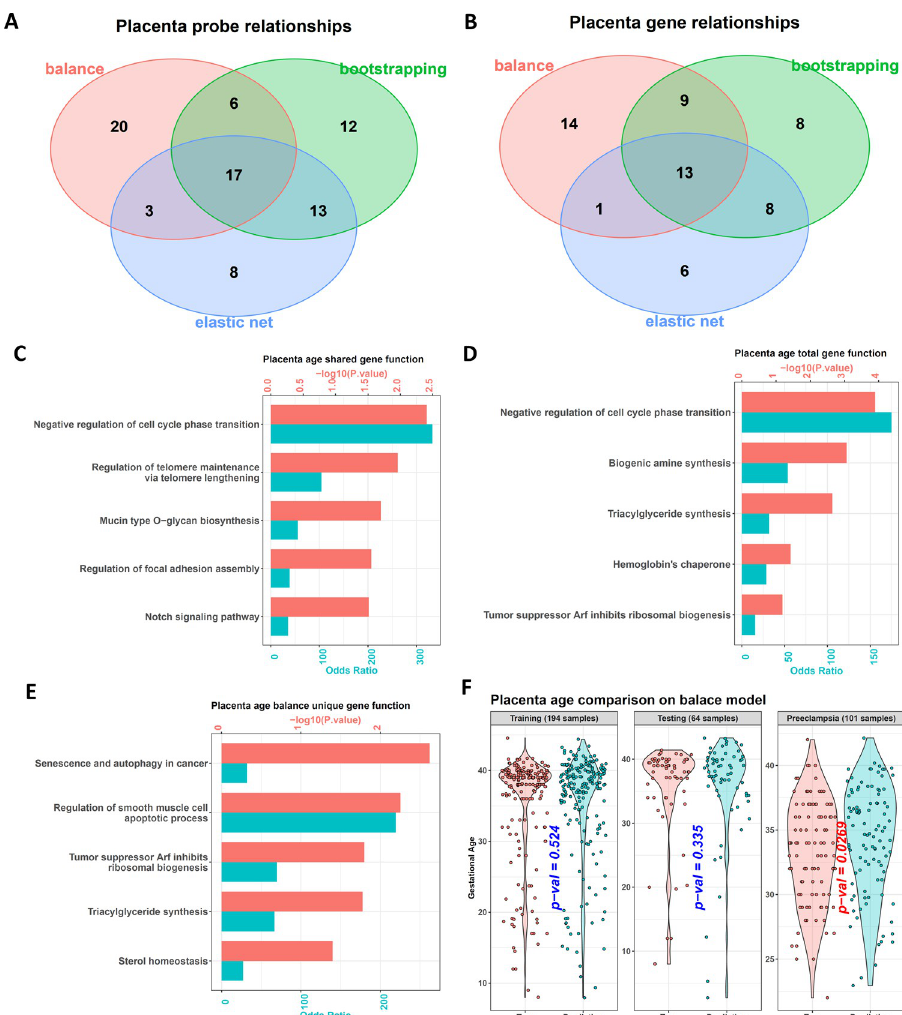
Fig 4. Biological functions of the probes selected from the gestational age dataset. (A) and (B) Venn diagrams showing the relation among the features selected by the three models for probes and genes, respectively. (C) to (E) Biological function enrichment results for the shared genes (C), total genes (D) of the three models, as well as the genes selected by the balanced model uniquely (E). (F) The balanced clock shows that the DNAm gestational ages of normal samples are similar to their chronological ones. However, the DNAm gestational ages of the preeclampsia samples are significantly larger than their chronological ones, indicating the accelerated